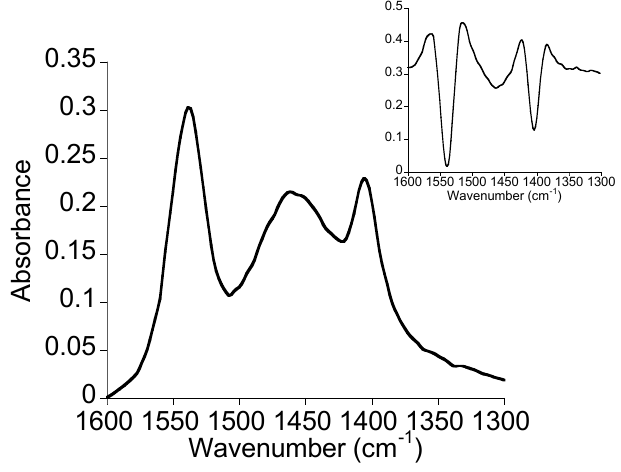
O-hydrated film of the bolaamphiphile 3 . ( A ) The Figure 2. FTIR spectra of the D 2 1,600–1,300 cm − 1 region; ( B ) the 3,050–2,800 cm − 1 region; ( C ) the 3,600-3,090 cm − 1